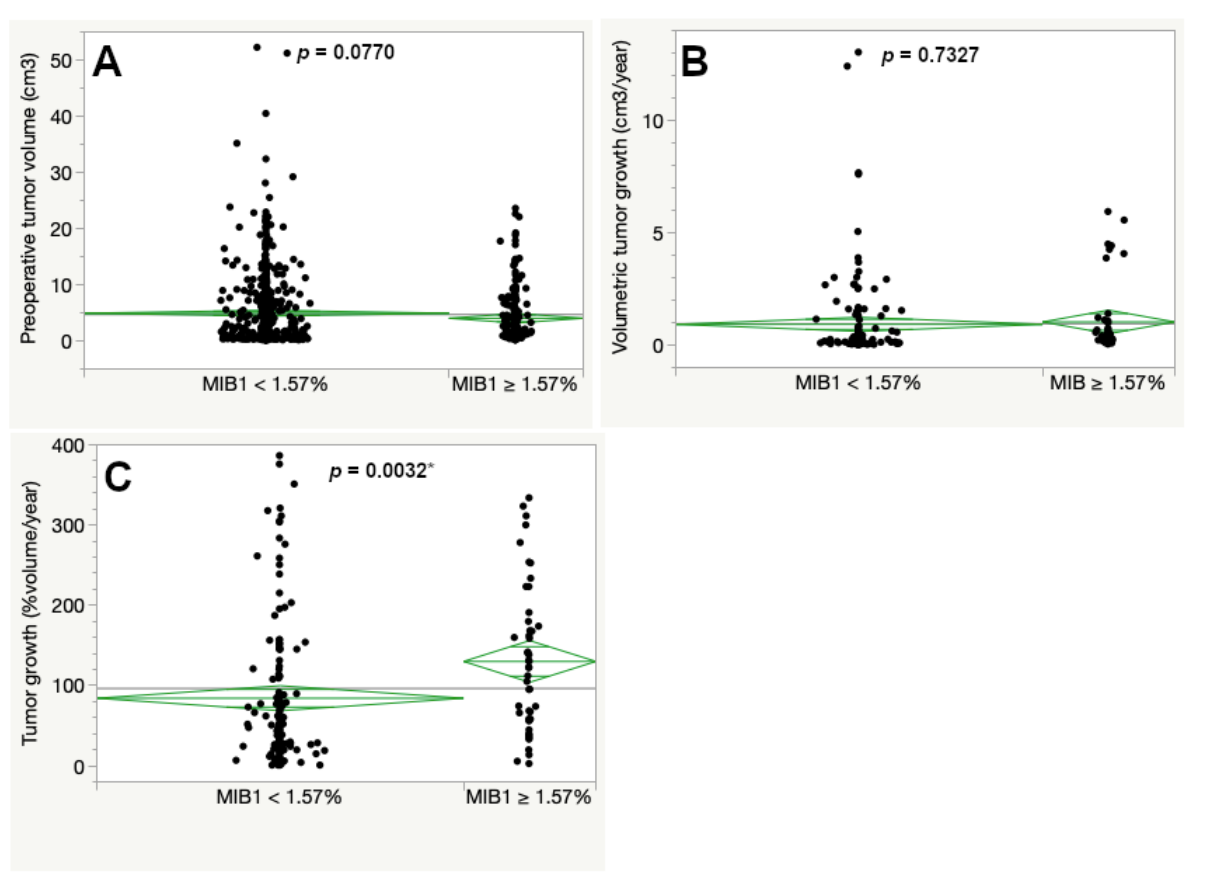
Figure 2. Preoperative tumor volume ( A ), volumetric tumor growth and ( B ) percentual volumetric tumor growth ( C ) in regard to the MIB1 expression in the tumor tissue. The cut-off at 1.57% was set according to a CART analysis regarding percentual volumetric growth (ANOVA; an asterisk (*) marks statistically significant results).